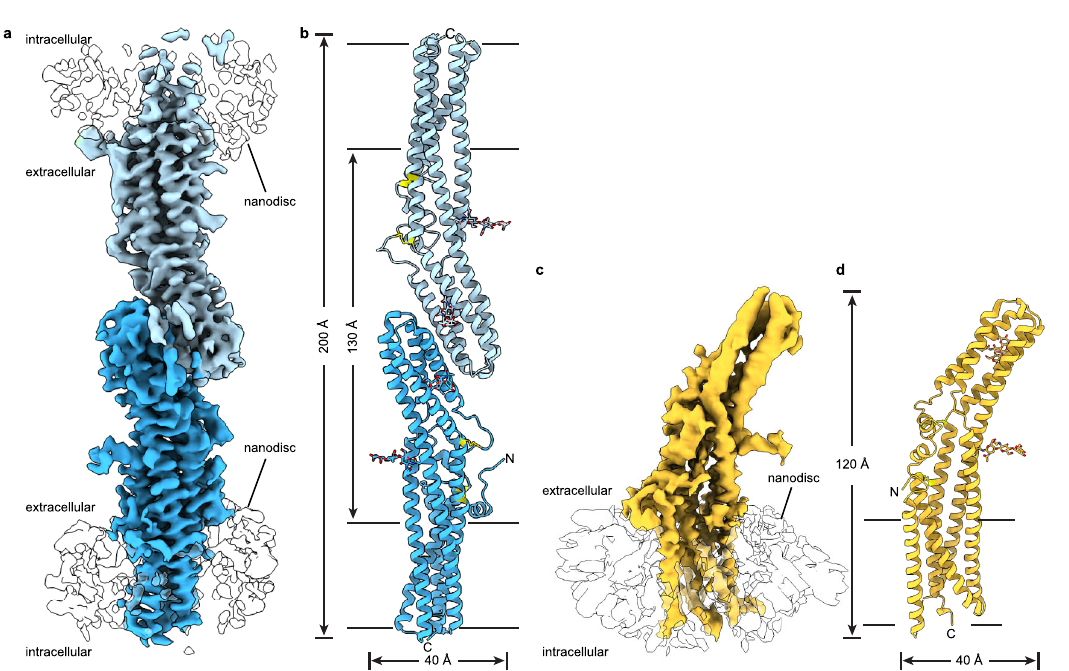
Fig. 3 Structures of a TTYH2 trans -dimer and monomer in the absence of Ca 2 + . a Cryo-EM map of a TTYH2 trans -dimer in MSP1E3D1 nanodiscs in the absence of Ca 2 + at 3.9 Å resolution viewed from the membrane plane. Density from the TTYH2 protomers is colored dark and light blue and the nanodiscs are white. b Model of the TTYH2 trans -dimer viewed from the membrane. N-linked glycosylation sites and disul fi de bonds in the extracellular domain are drawn as sticks. c Cryo-EM map of a TTYH2 monomer in MSP1E3D1 nanodiscs in the absence of Ca 2 + at 4.0 Å resolution viewed from the membrane plane. Density from the TTYH2 protomer is colored orange and the nanodisc is white. d Model of the TTYH2 monomer viewed from the membrane. N-linked glycosylation sites and disul fi de bonds in the extracellular domain are drawn as